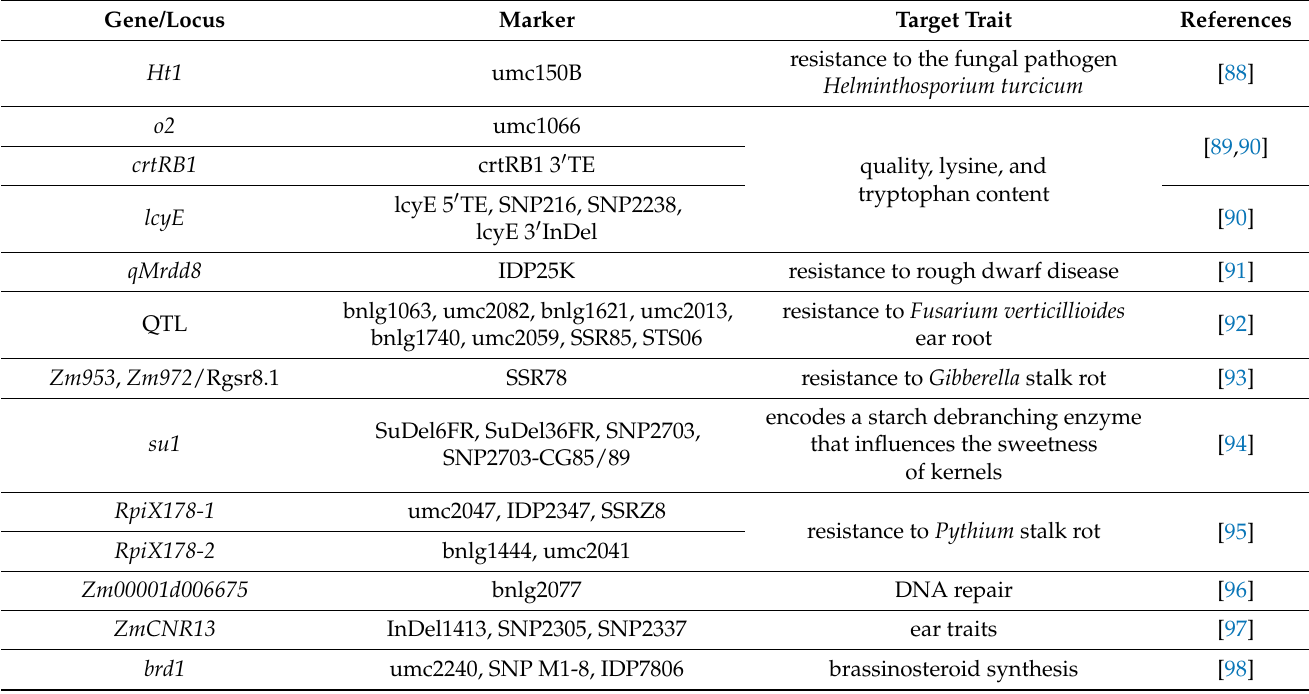
Table 2. Summary of significant molecular markers for Zea mays . Gene/Locus Marker Target